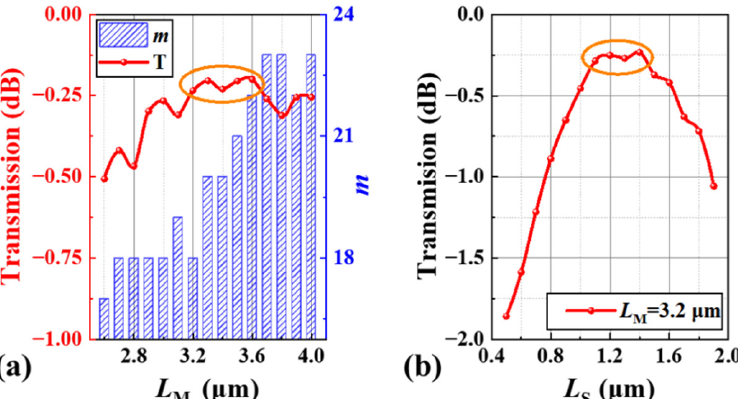
Figure 4. ( a ) Device transmission with MMI length L M and optimal half period number m of the embedded SWG structure in the power splitter. SWG period number n = m /2. ( b ) Device transmis ‐ sion with the gap length L S , where L M = 3.2 μ m. The marked regions represent the recommended structural parameter ranges.